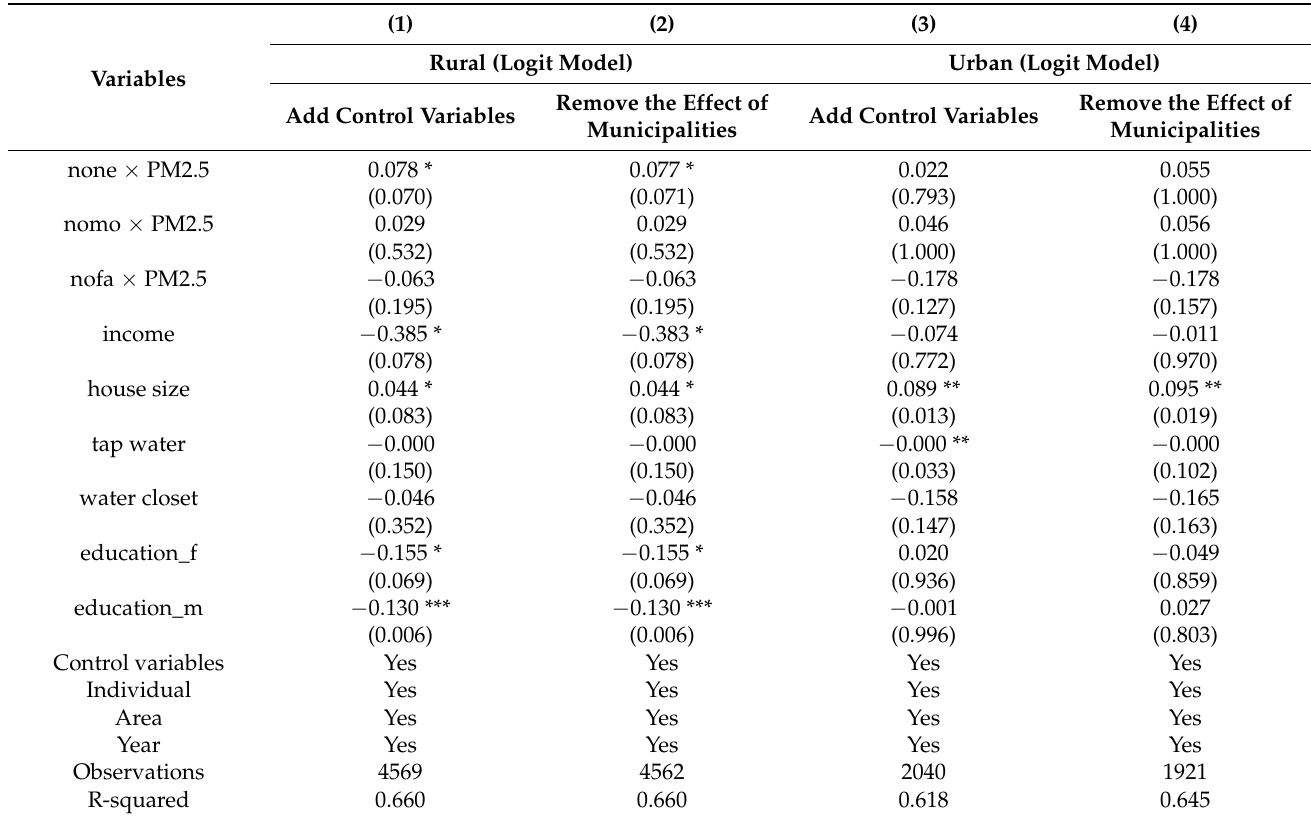
Table 3. Robustness test